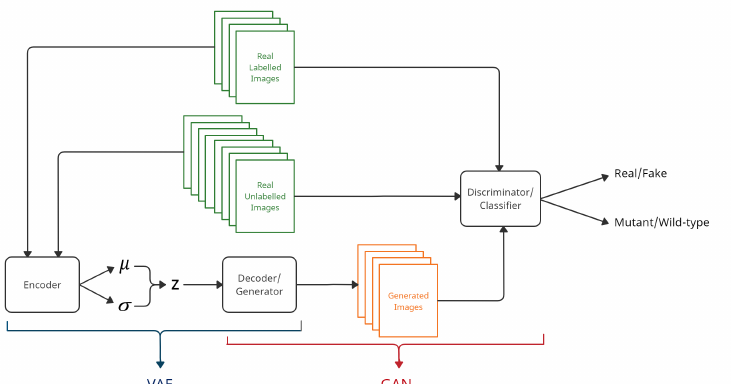
Figure 2. Proposed method, which consists of two main structures linked by a shared network: a VAE and a semi-supervised GAN, with the VAE decoder acting as the GAN